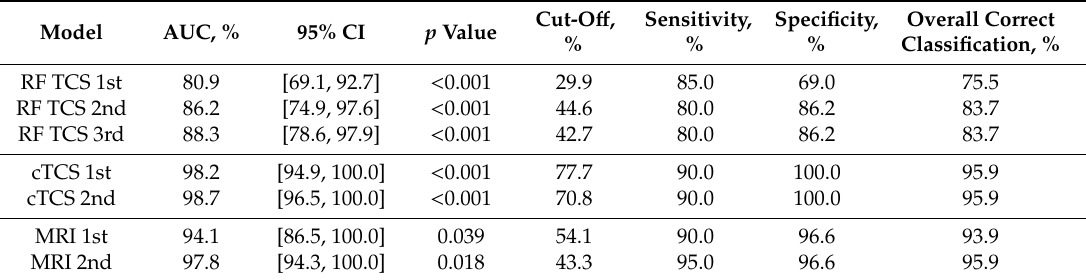
Table 3. ROC analysis of the predicted probability of logistic regression models for the likelihood that the subject has Parkinson’s disease.